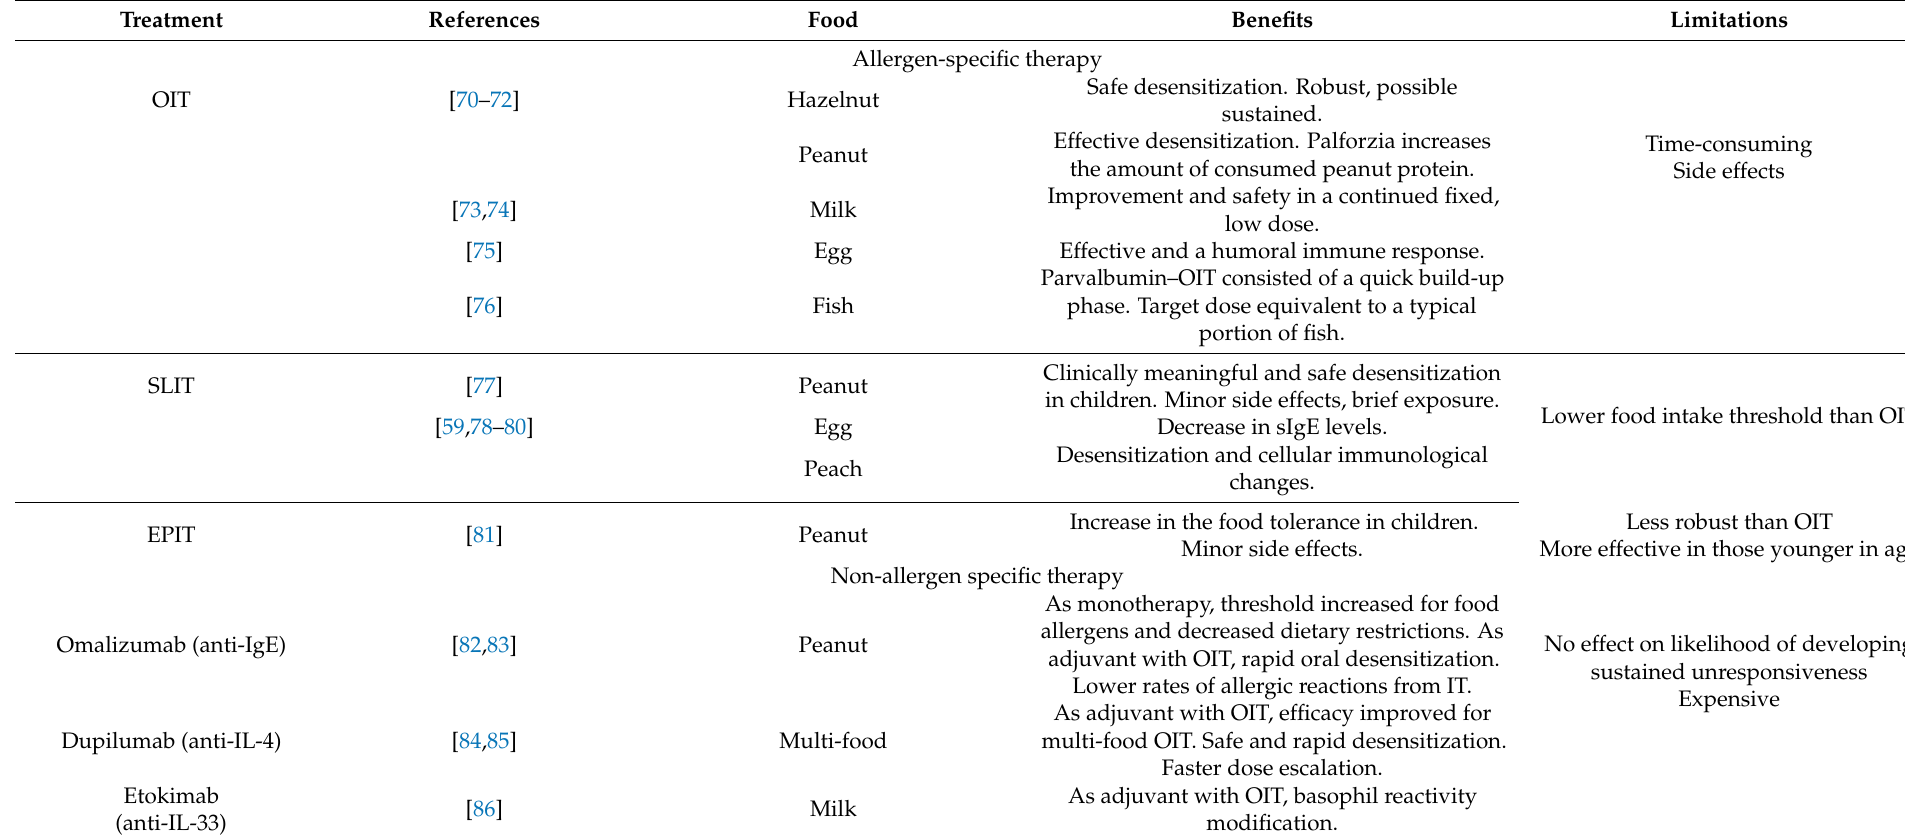
Table 1. Summary of the therapeutic approaches for FA in the last 5